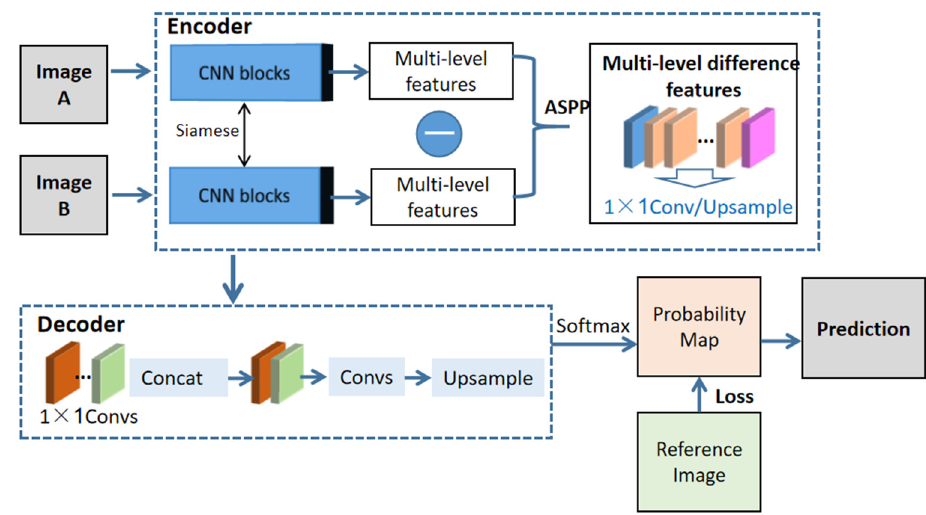
Figure 1. The overall workflow of the proposed methodology.